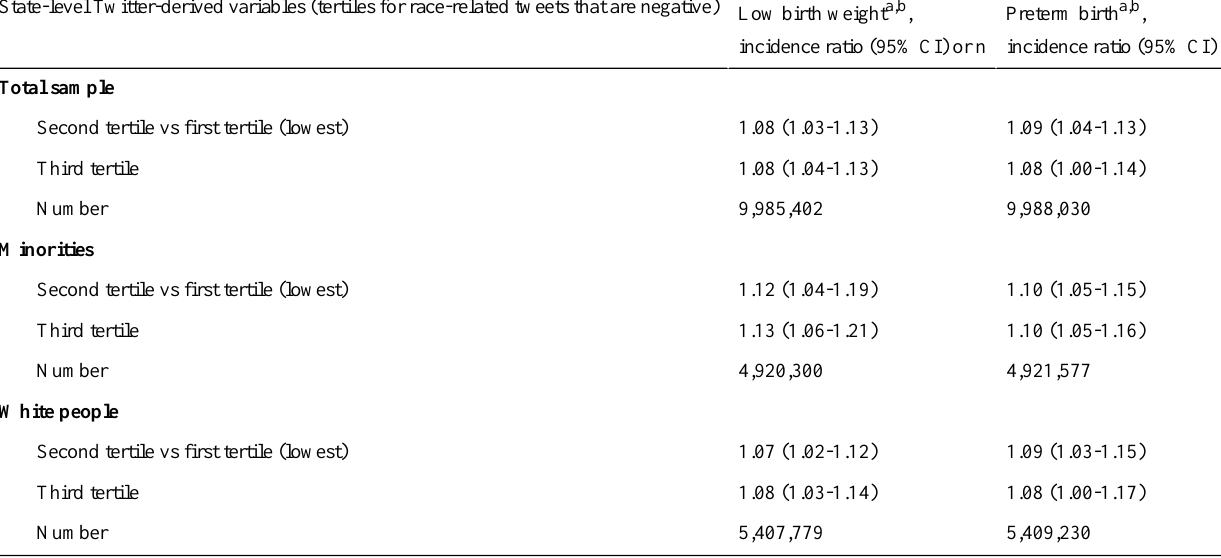
Table 4. State-level sentiment toward racial or ethnic minorities and individual-level birth